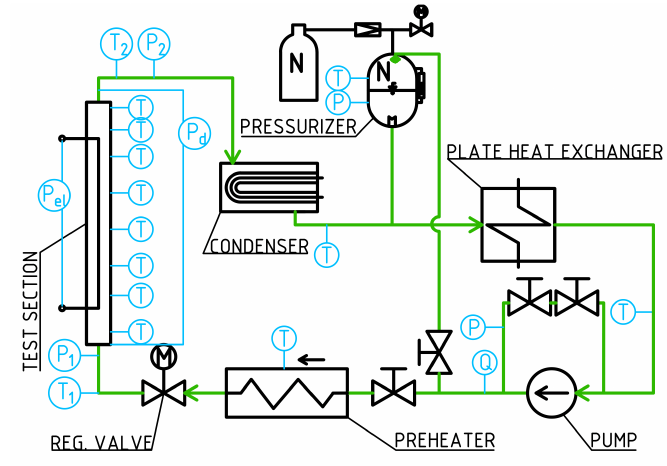
Figure 1. Process flow diagram of the Mobile Research Critical Heat Flux Apparatus (MRCHA) test facility primary